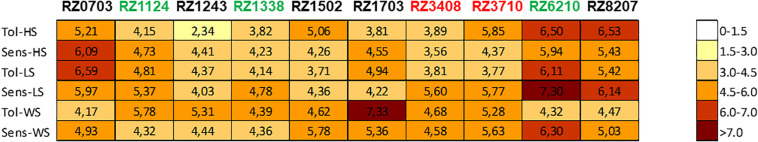
Stress matrix built using the average of the | log2(gene expression ratio)| of HS/LS/WS DEGs (as in Supplementary Table 6) that yielded a significant value (| >1.5|) of the expected regulation (down-/up-). Expression in relation to Tol, tolerant; Sens, sensitive; HS, heat stress; LS, light stress; WS, water stress.